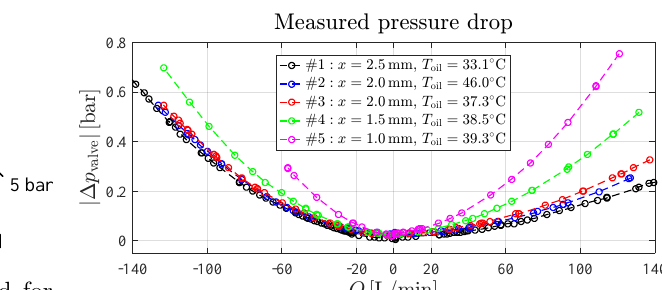
Figure 10: Hydraulic schematic of the setup used for experiments.